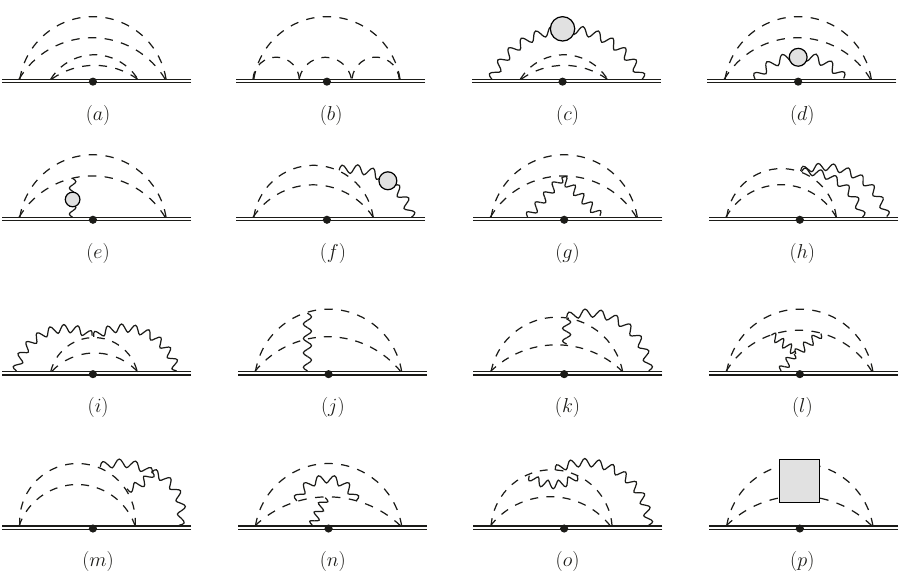
Figure 1 . List of planar diagrams contributing to the four-loop θ -Bremsstrahlung function. Gray bullets stand for 1-loop corrections to the gauge propagator. The gray box collects the two-loop corrections to the bi-scalar two-point function.